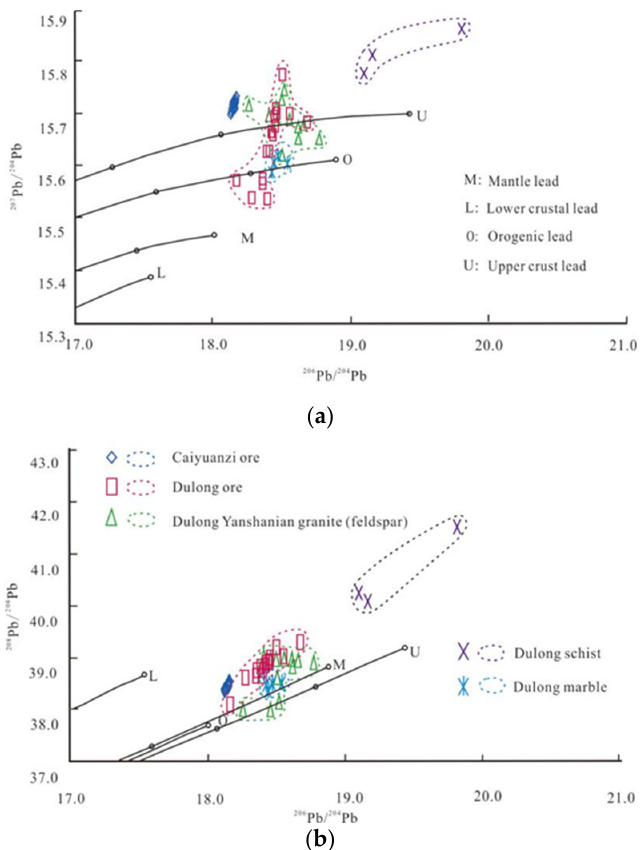
Figure 9. The Pb model diagram for the Caiyuanzi deposit (base map is modeled after [38,62], and lead isotope data of samples in the Dulong ore area are quoted from [43]). ( a ) The samples of the Caiyuanzi deposit fall on the average upper crustal growth curve. ( b ) The mantle curve in the corresponding.